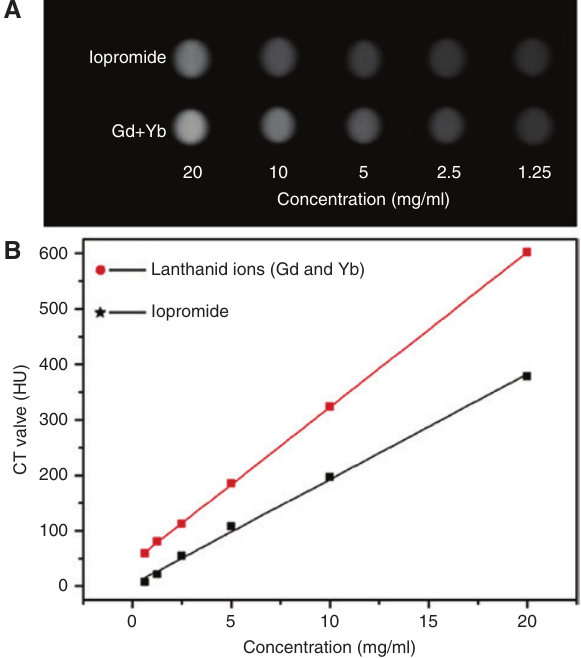
Figure 20: In vitro CT images of UCNPs with different lanthanide ion concentrations (A), and CT value (HU) of samples as a function of lanthanide ions (Gd and Yb) concentrations